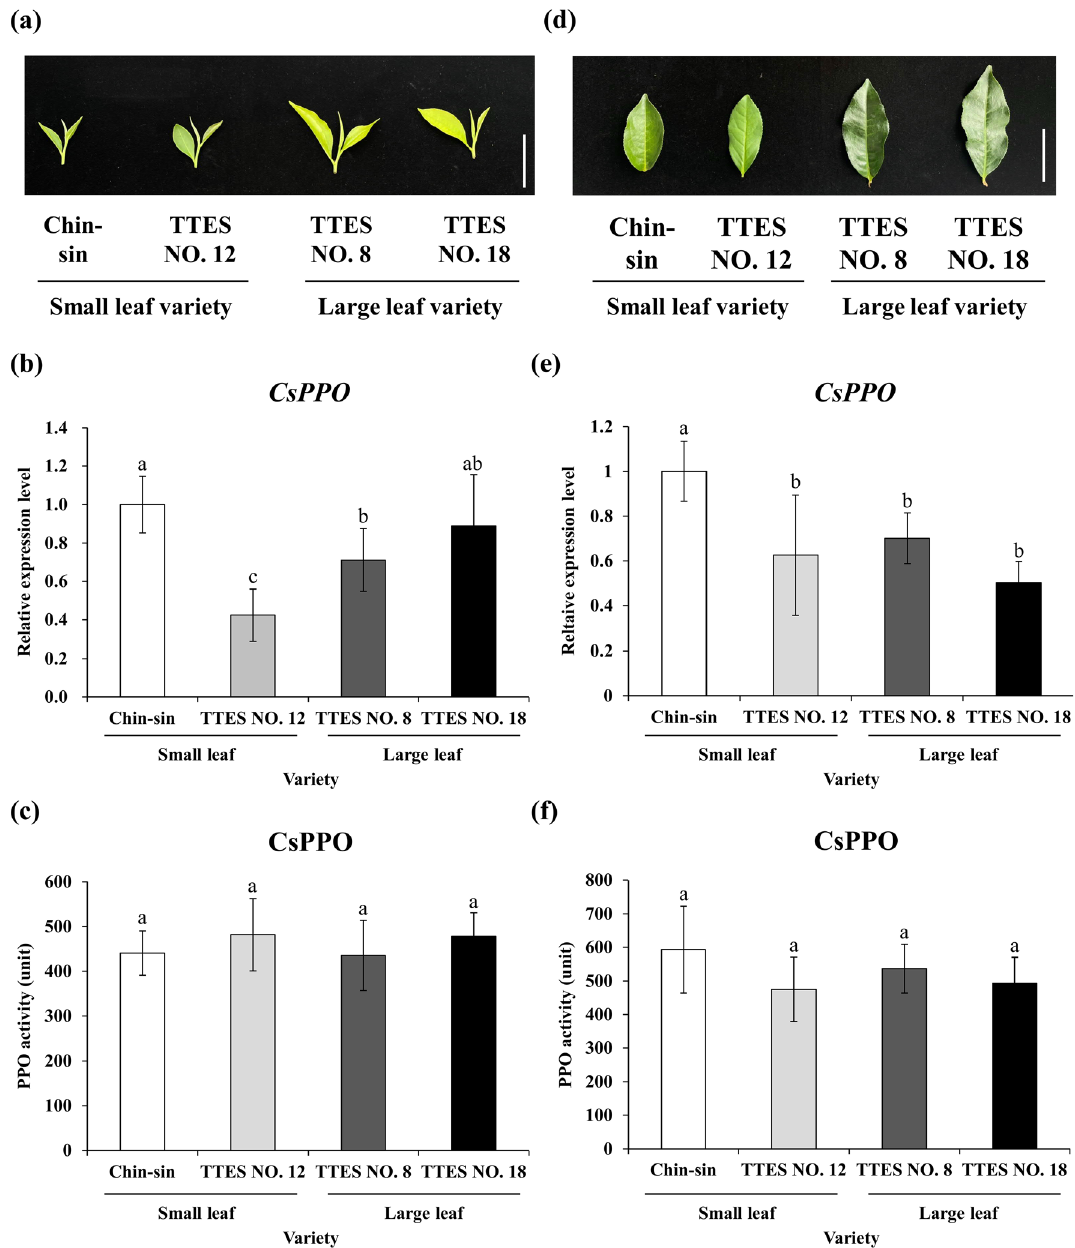
and old leaves of each variety. CsPPO transcript levels were measured using qRT-PCR and normalized to that of 18S rRNA. One unit of PPO activity was defined as the amount of enzyme required to metabolize pyrocatechol into a micromole of benzoquinone per minute. Values are presented as the mean ± SD of three biologically independent experiments. Different letters indicate significant difference between varieties assessed using the LSD post hoc test ( p < 0.05). Bar = 5